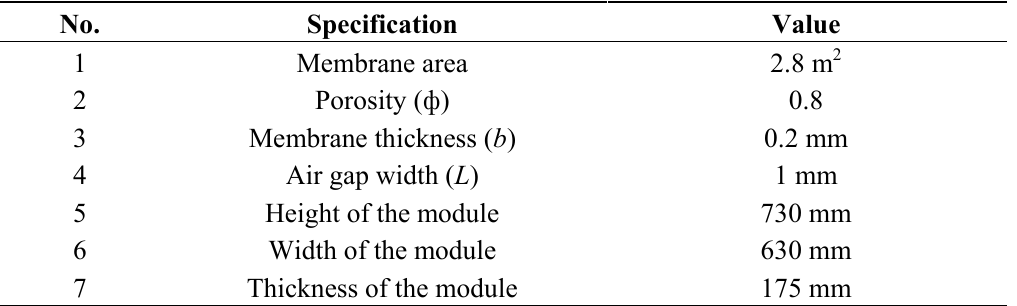
Table 1. Technical specifications of membrane module [16]. Copyright 2011 KTH Royal Institute of